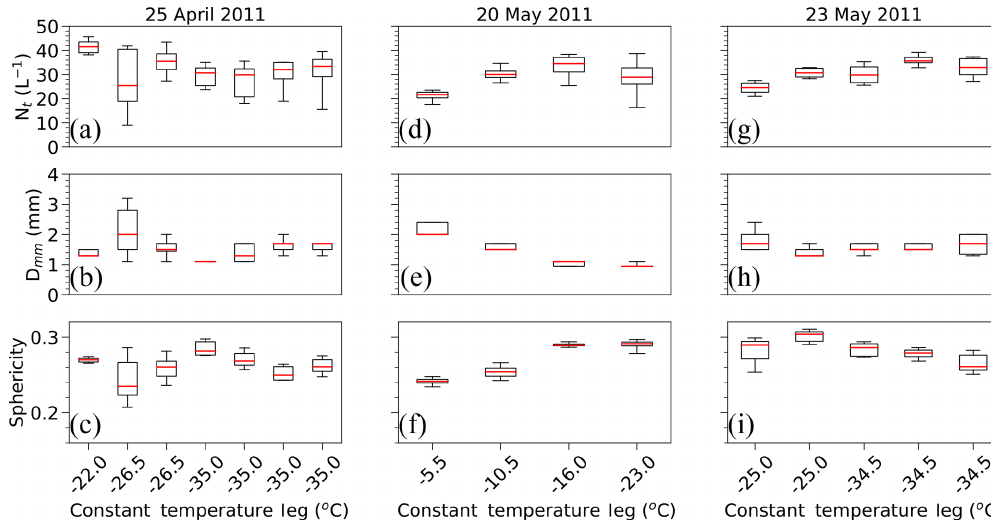
Figure 12. As in Fig. 6, but for number concentration N t , median mass diameter D mm , and mass-weighted mean sphericity.